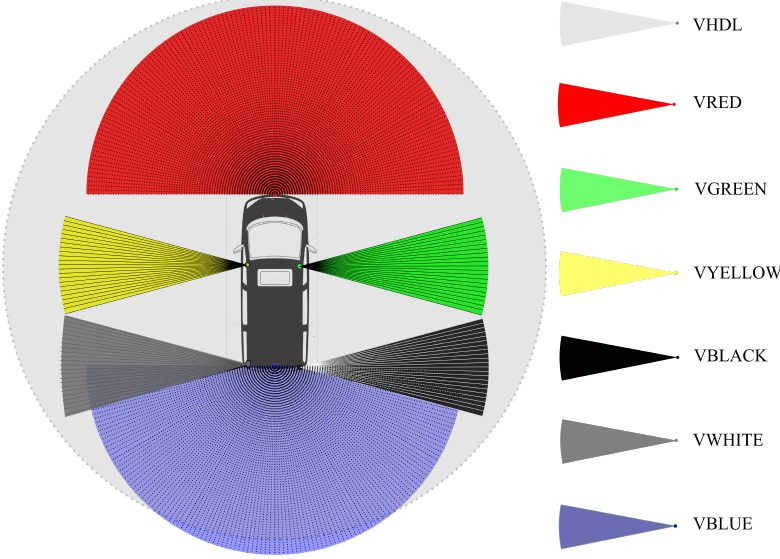
Figure 2. Field of views of the LiDAR sensors around the GPSVan.